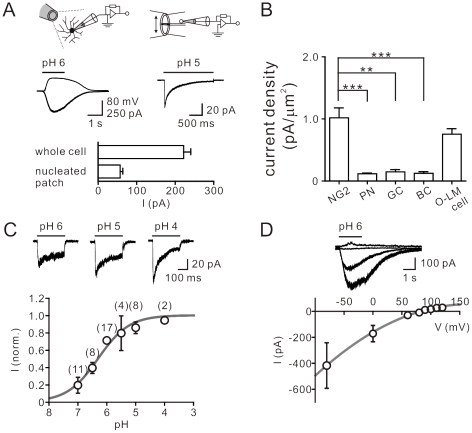
ASIC currents are present in NG2 cells.(A) Top, schematics of whole-cell (left) and nucleated patch (right) recordings. Middle left, puffer application of acid onto an NG2 cell elicited inward currents (V-clamp at −80 mV) or membrane depolarization (I-clamp, V
m  = −80 mV before the pulse). Middle right, ASIC currents evoked by fast application technique in a nucleated patch from an NG2 cell (V-clamp at −60 mV). Bottom, summary of acid-evoked ASIC currents. (B) ASIC current density in NG2 cells compared to various types of neurons in the CA1 area and dentate gyrus. PN, pyramidal neuron; GC, granule cell; BC, basket cell; O-LM cell, oriens lacunosum-moleculare cell. **P<0.005; ***P<0.0005. (C) Top, ASIC currents evoked by different pH reductions. Bottom, the normalized peak amplitude of ASIC current plotted against the pH value. Data fit with the Hill equation. (D) Top, overlay of ASIC currents recorded at different potentials (−80, 0, +80 and +100 mV). Bottom, the I-V relationship had the reversal potential of +85 mV. Data (pooled from 8 cells) fit with a polynomial function.